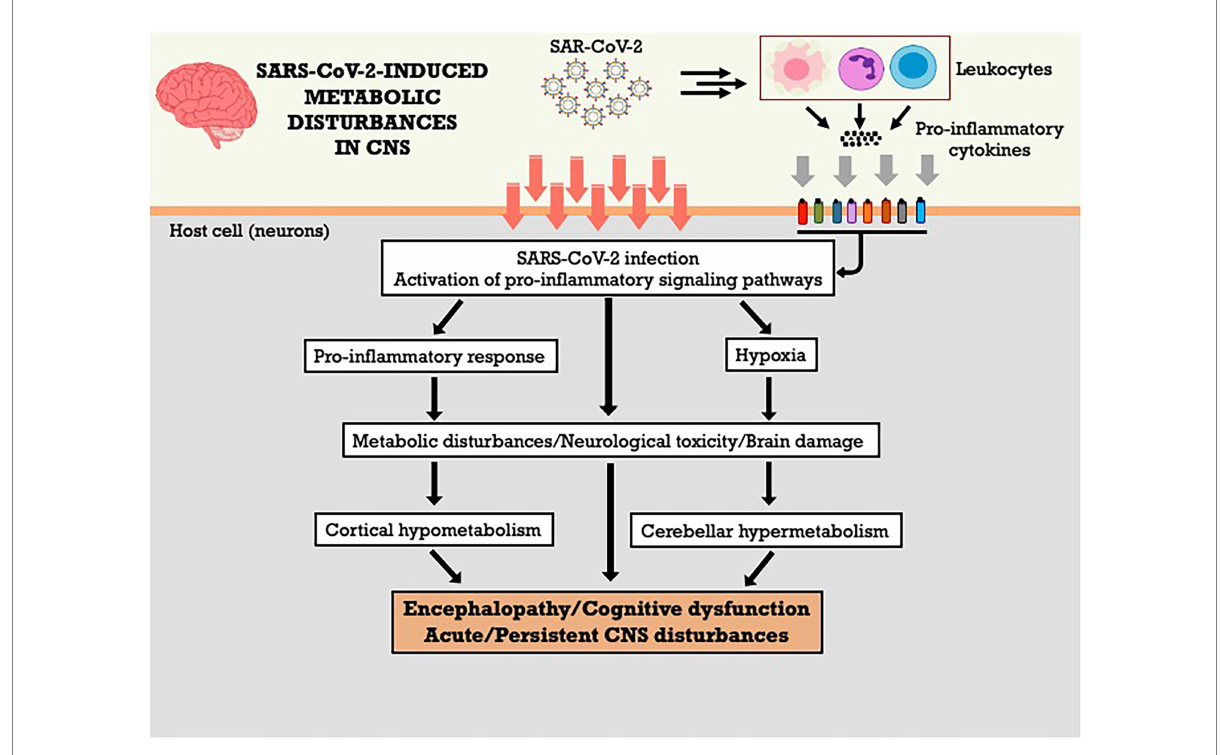
FIGURE 1 SARS-CoV-2-induced metabolic disturbances in central nervous system. CNS, central nervous